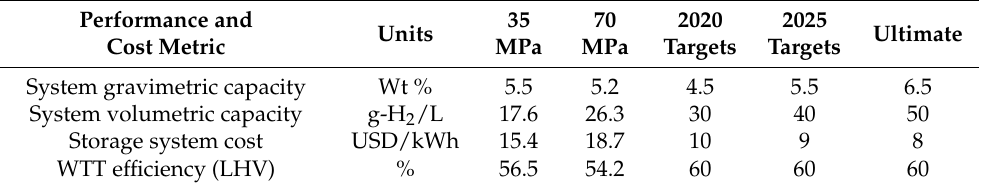
Table 2. Summary results of assessment for CH 2 storage system compared to DOE targets [42,43].